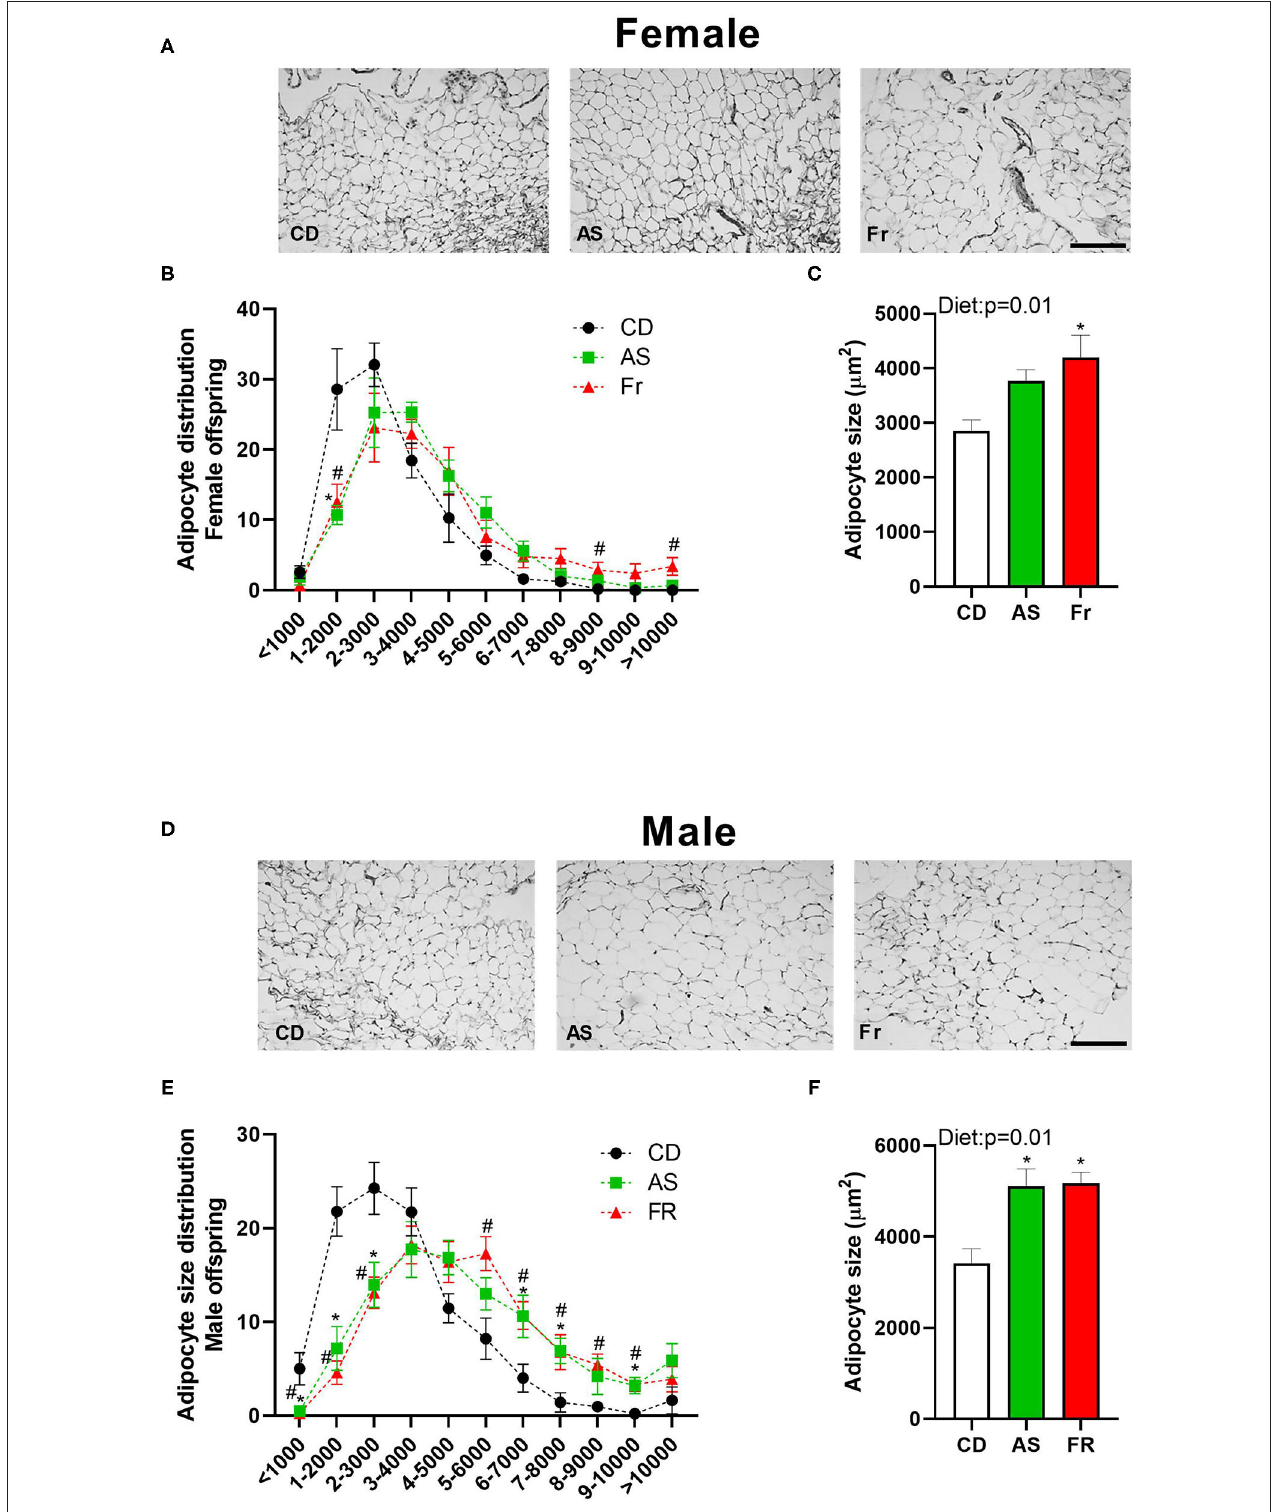
FIGURE 2 | The impact of maternal Ace-K (AS) and fructose (Fr) intake compared to Controls (CD) on adipocyte size in gonadal adipose tissue in female and male C57BL/6 offspring. Representative gonadal adipose tissue sections (hematoxylin and eosin staining) in female (A) and male (D) offspring. Adipocyte size distribution in female (B) and male (E) offspring. Adipocyte average size in female (C) and male (F) offspring. Data were analyzed by one-way ANOVA. Data are expressed as mean ± SEM. * P < 0.05 AS w.r.t CD. # P < 0.05 Fr w.r.t CD; n = 8 per sex per group.